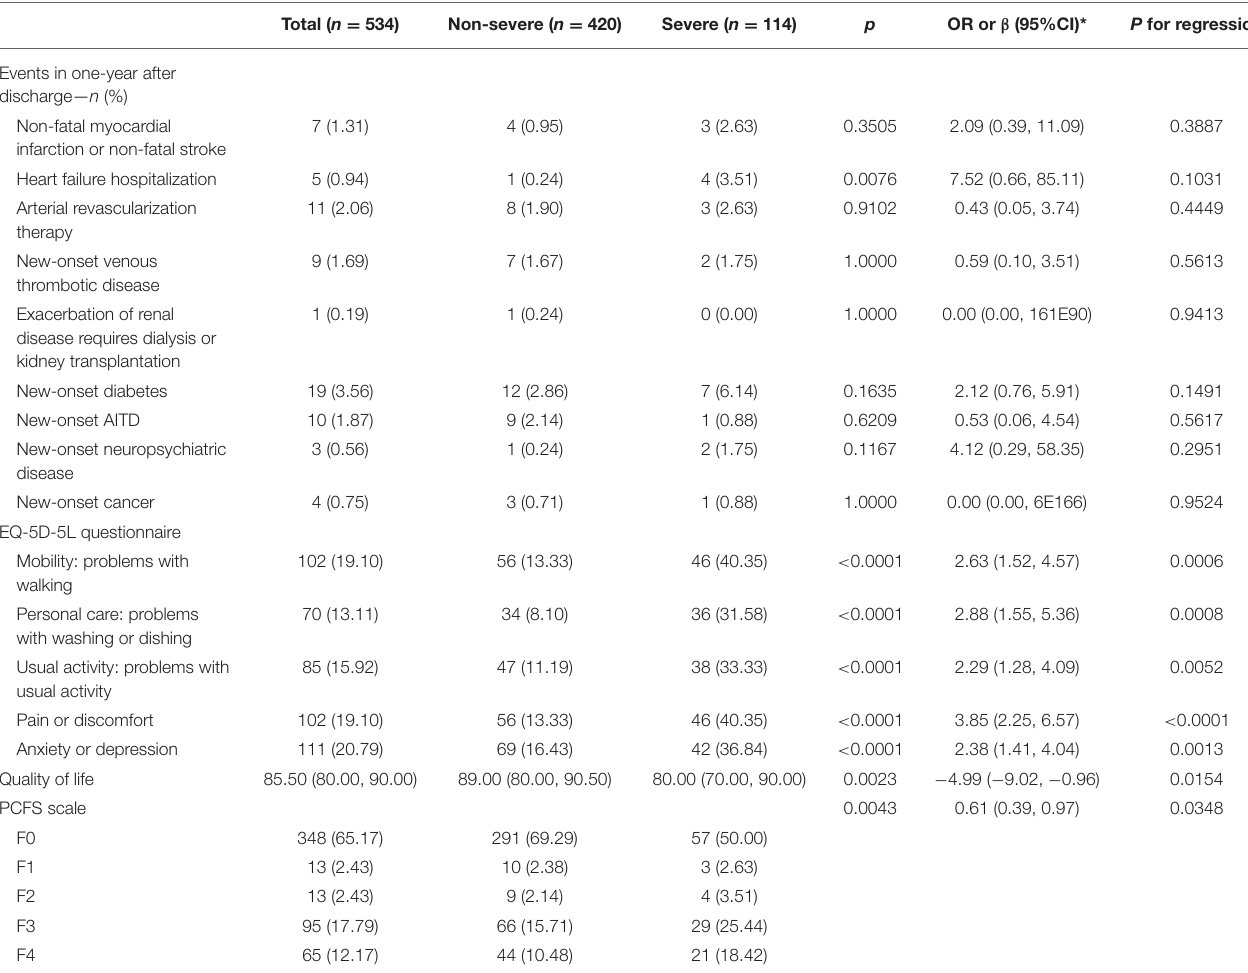
TABLE 3 | Health-related quality of life, PCFS scales and extrapulmonary organ function at 15-month follow-up. Total ( n = 534) Non-severe ( n = 420) Severe ( n = 114) p OR or β (95%CI)* P for